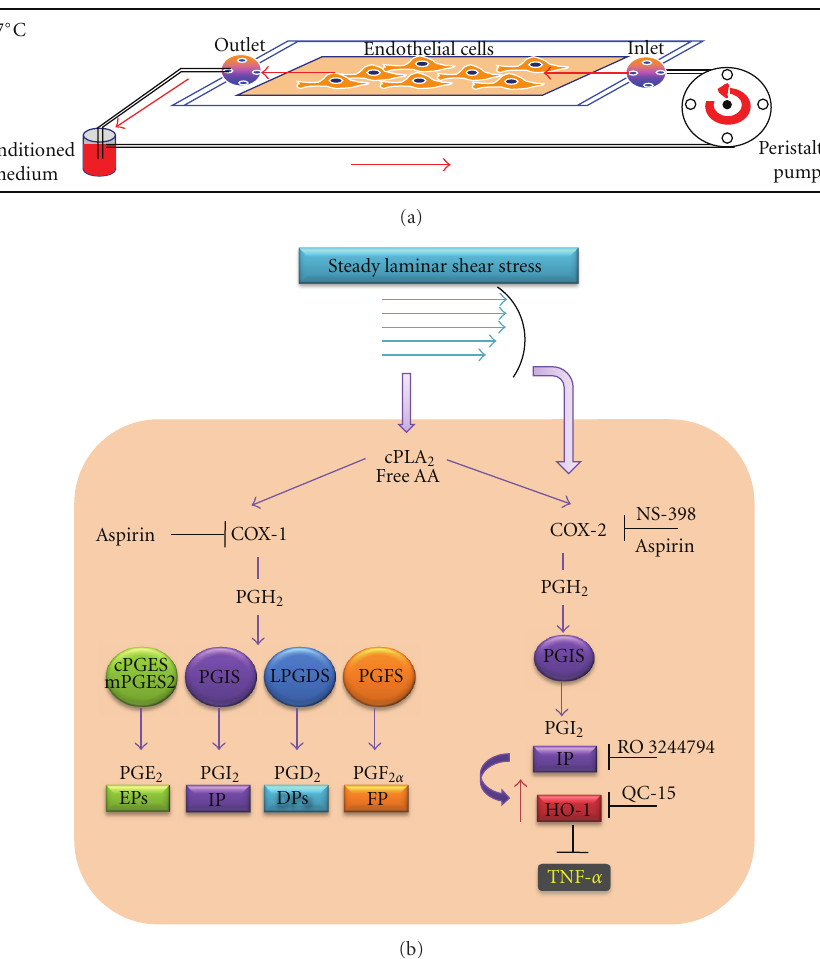
Figure 1: Exposure of endothelial cells to steady laminar shear stress (LSS). (a) HUVECs (0.8 to 1 × 10 6 cells per glass slide) are shear stressed using a parallel plate flow chamber connected to a constant pressure drop flow loop, maintained at 37 ◦ C and gassed continuously with a humidified mixture of 5% CO 2 in air. Endothelial monolayers are continuously perfused in a closed circuit at an estimated shear stress of 10 dyn/cm 2 (flow rate of 2.53mL/min; shear rate of 1400 sec − 1 ) with 7mL of perfusion DMEM-medium199 (50% vol/vol), supplemented with 5% fetal calf serum, 1% glutamine, and antibiotics for 6 hours [11]. (b) In HUVEC, steady LSS activates cPLA 2 , thus releasing free arachidonic acid (AA) from cell membrane phospholipids, the substrate of cyclooxygenase isoenzymes (COX-1 and COX-2). In addition, LSS upregulates COX-2 expression in HUVEC, without a ff ecting the expression of COX-1 and downstream synthases (such as cPGES, mPGES2, PGIS, LPGDS, PGFS) [11]. Both COX-1 and COX-2 participate in the biosynthesis of PGE 2 , PGI 2 , PGD 2 , and PGF 2 α as suggested by the finding that aspirin (a nonselective COX inhibitor) a ff ects the levels of all these prostanoids. Di ff erently, the selective COX-2 inhibitor (NS-398) a ff ected only PGI 2 in HUVECs exposed to LSS which overexpressed COX-2. COX-2-dependent PGI 2 , induced by LSS, through the interaction with a specific receptor (IP), causes the induction of HO-1. It constrains TNF- α biosynthesis in HUVECs under this experimental condition. In fact, LSS-dependent reduction of TNF- α generation is completely countered by the selective COX-2 inhibitor NS-398, the nonselective COX inhibitor aspirin, or the specific PGI 2 receptor (IP) antagonist RO3244794 [11, 12]. Finally, by the use of the novel imidazole-based HO-1 inhibitor QC15 [13], it has been shown that HO-1 induction in response to COX-dependent PGI 2 plays a role in LSS-dependent reduction of TNF- α biosynthesis